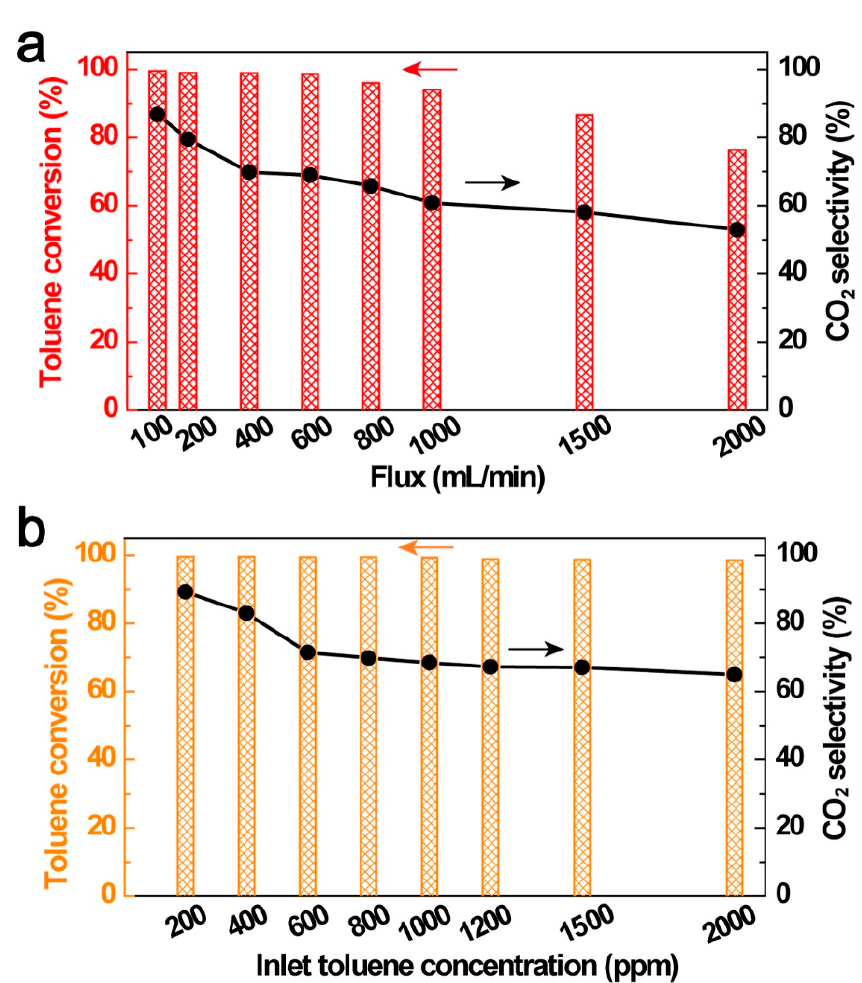
Figure 6. Influences of flux ( a ) and inlet toluene concentration ( b ) on toluene conversions. (bar: toluene conversion, dot line: CO 2 selectivity) (IPC length = 15 cm, RH = 0%, ambient temperature = 25 °C).